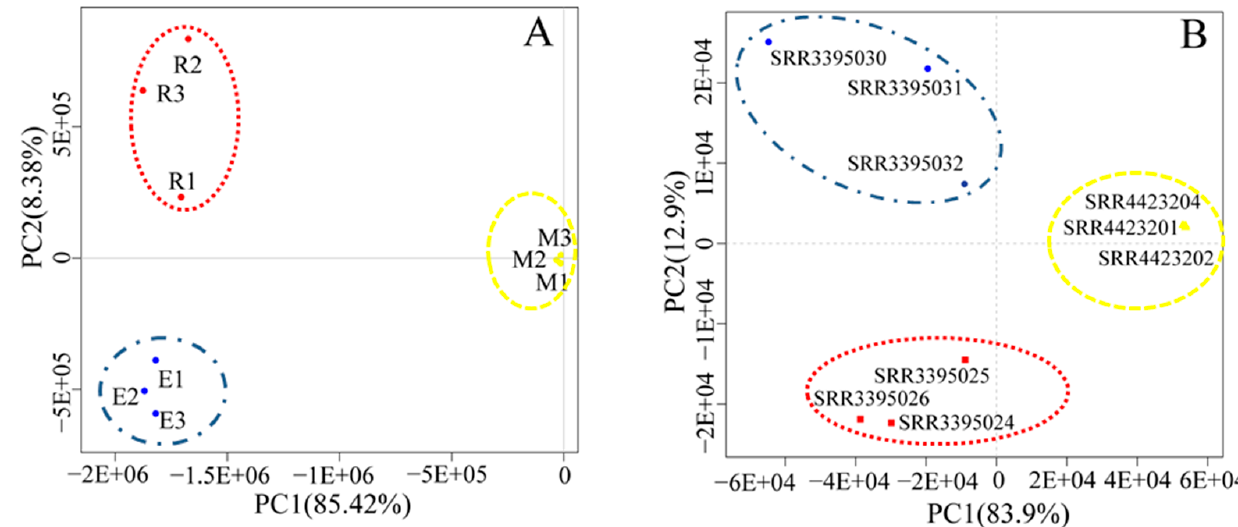
Figure 2. Principal component analysis (PCA) results. Bovine ( A ) and mouse ( B ) PCA graphs of transcript expression in round spermatids, elongated spermatids, and epididymal sperm. PCA plots of RNA-Seq data show the characteristics of samples according to gene expression (FPKM) levels, with each dot indicating a sample. The red dotted circle represents round spermatids, the blue dotted circle represents elongated spermatids, and the yellow dotted circle represents epididymal sperms. The horizontal axis represents the first principal component (PC1), whereas the horizontal axis represents the first principal component (PC2). FPKM: fragments per kilobase of transcript per million mapped reads.